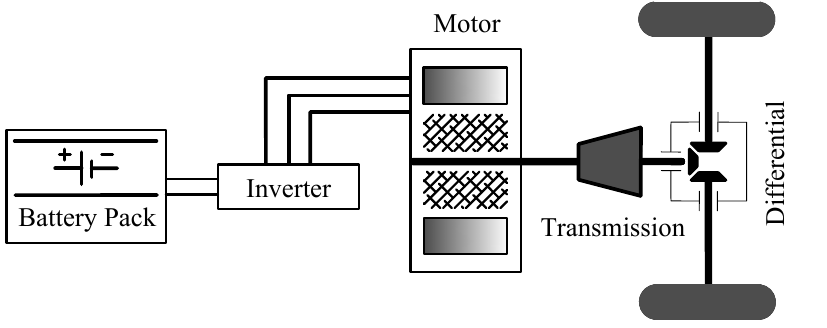
Figure 1. Architecture of the power train of EV.